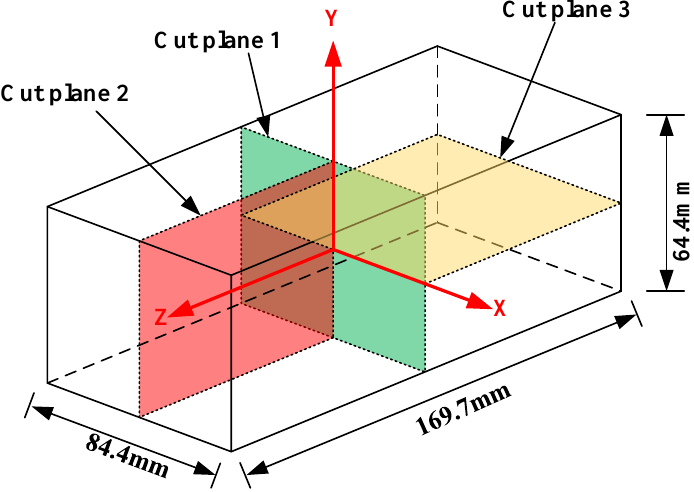
Figure 4. Dimensions of the TiB 2 /7050 Al composite extrusions and three-cut planes used to map residual stress in the extrusion.